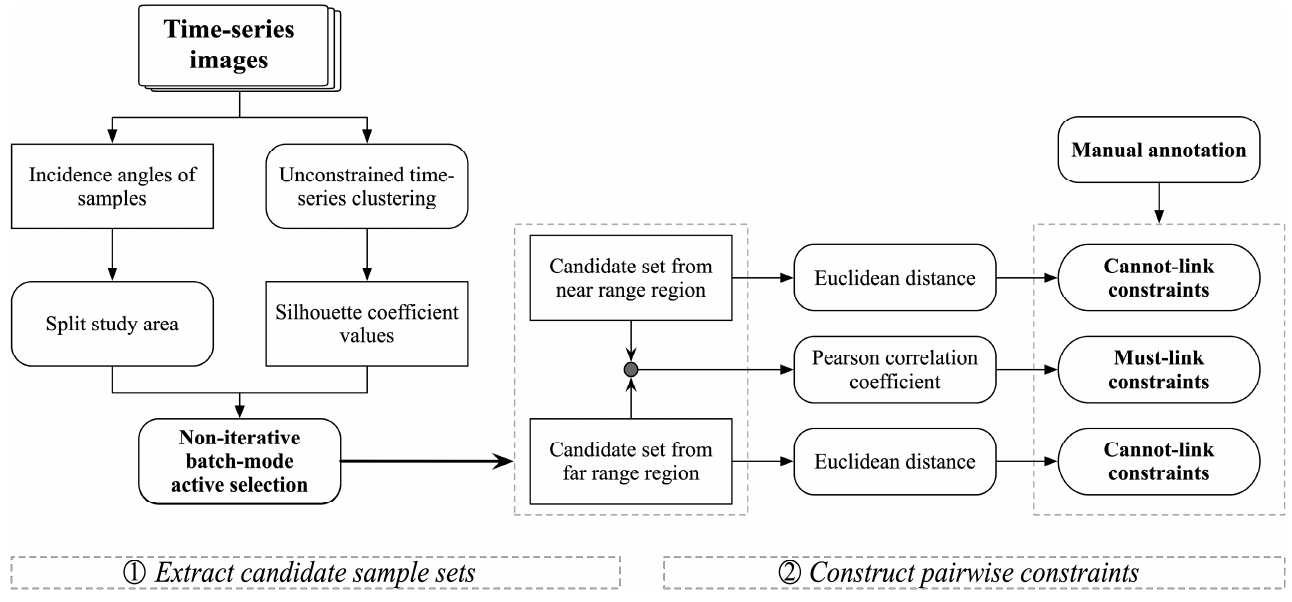
Figure 4. Flowchart of the proposed active pairwise constraint learning method.